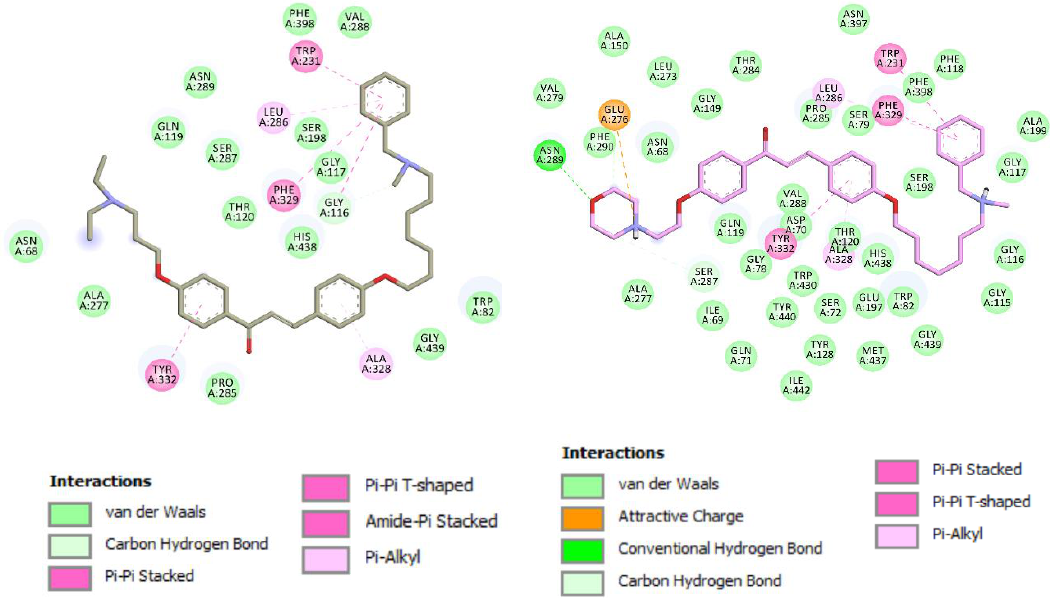
Figure 5. 2D Schematic representation of different interactions of compounds 4 ( left ) and 6 with h BuChE ( right ).